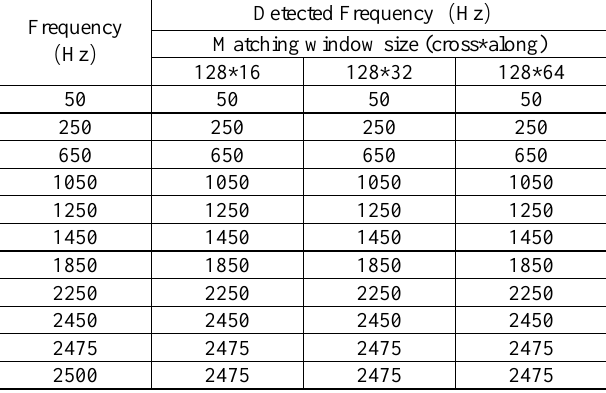
Table 2. Jitter frequency detection results with different matching window size